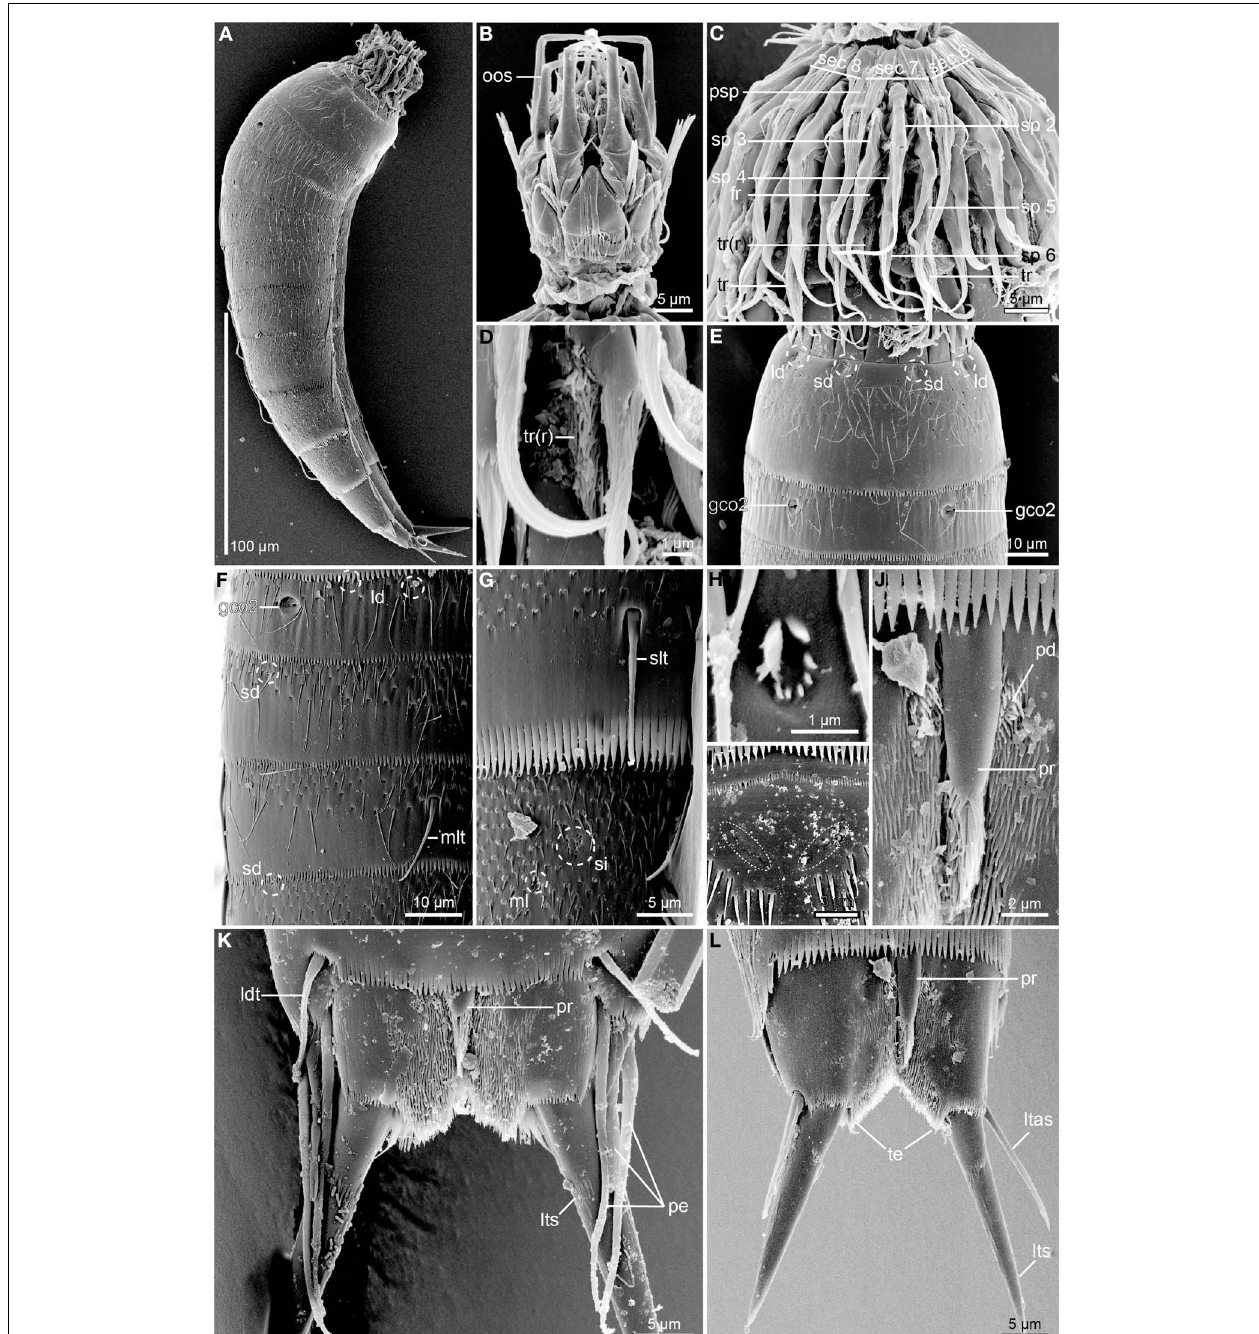
FIGURE 5 | Scanning electron micrographs of Echinoderes augustae sp. nov. (A) Female paratype (ZMUC KIN-719); (B–G) . female paratype (ZMUC KIN-729); (H–I) . and (K) male paratype (ZMUC KIN-725); (J,L) . female paratype (ZMUC KIN-721). (A) Lateral overview. (B) Mouth cone, dorsal view, anterior to introvert section 6. (C) Introvert, showing introvert section 7 in the center. (D) Detail of introvert section 7, showing reduced trichoscalid. (E) Segments 1 to 2, dorsal view. (F) Segments 2 to 4, lateral view. (G) Detail of segments 8 to 9, showing sublateral tubule and sieve plate. (H) Detail showing middorsal sensory spot on segment 2. (I) Detail showing middorsal area, anterior to spine, on segment 4. Note the pore fields of the glandular cell outlets (marked with dashed